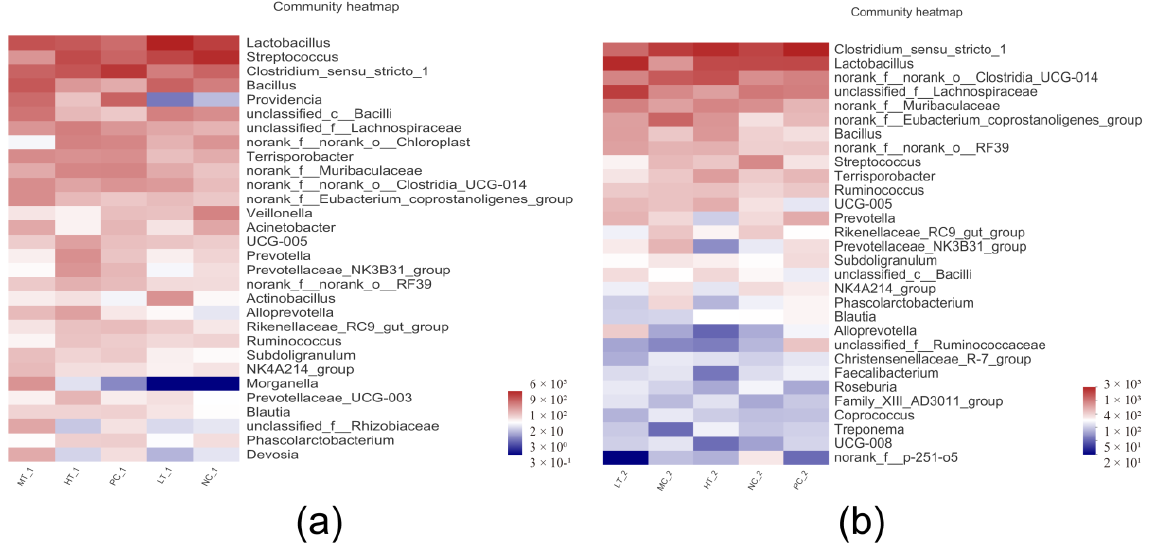
Figure 7. Heatmap in the jejunum and colonic digesta of weaned pigs at the genus level. ( a ) Community heatmap of jejunal microbial communities at the genus level. ( b ) Community heatmap of colonic microbial communities at the genus level. NC, a control diet; PC, NC + 150 ppm mucilage sulfate; LT: 1 kg/t joint application of Lactobacillus Plantarum and Bacillus subtilis ; MT: 1.5 kg/t joint application of Lactobacillus Plantarum and Bacillus subtilis ; HT: 2 kg/t joint application of Lactobacillus Plantarum and Bacillus subtilis .